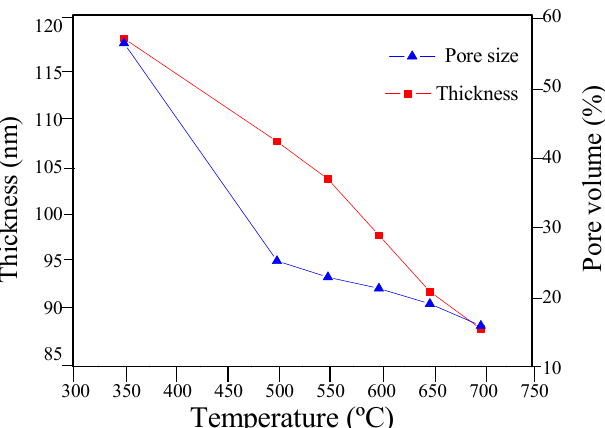
Figure 1. Variation of the thickness and pore volume (%) as a function of the temperature for the mesoporous LTO thin